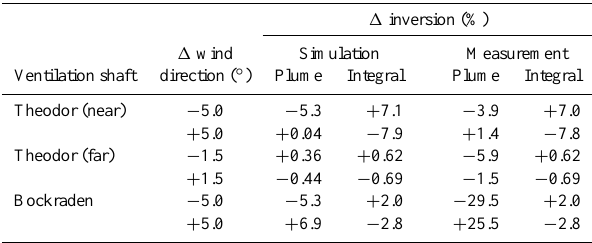
Table 3. Error on simulated and measured inversion results due to uncertainty on wind direction. 1 inversion (%) 1